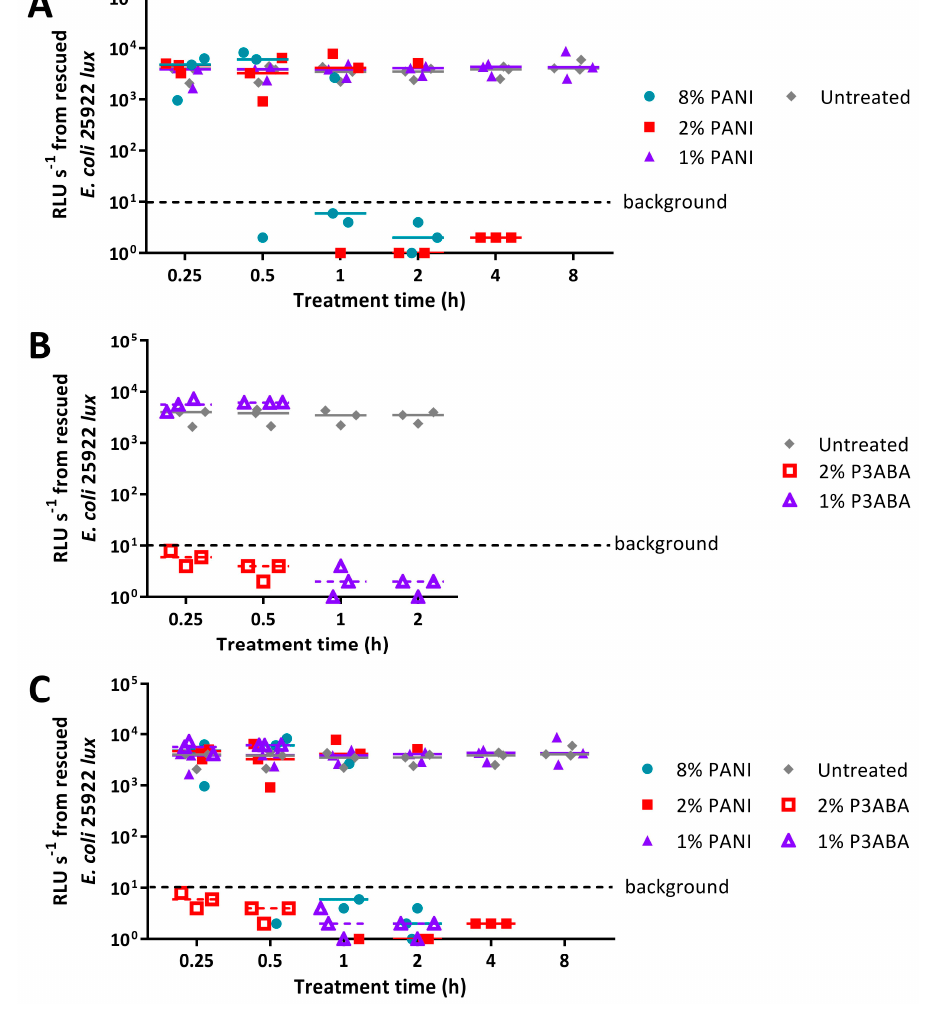
Figure 4. Sensitivity of E. coli 25922 lux to PANI and P3ABA in agar. ( A ) ~10 4 CFU of E. coli was exposed to 8% PANI, 2% PANI, and 1% PANI incorporated into LB agar for 0.25 h, 0.5 h, 1 h, 2 h, 4 h, and 8 h. ( B ) ~10 4 CFU of E. coli was exposed to 2% P3ABA and 1% P3ABA incorporated into LB agar for 0.25 h, 0.5 h, 1 h, and 2 h. Following treatment, the cells were rescued by washing the agar surface with LB broth and transferred to a 96 well plate. Each point represents the median of three technical replicates and each bar represents the median of each biological replicate. The data from A and B is combined for comparison in ( C ). The rescued cells were incubated at 37 °C for 16 h and light release was measured. The vertical axis shows the bioluminescence measurements (relative light units per second, RLU s − 1 ) from the recovered cells with each data point representing an independent experiment and the line representing the median. Background luminescence readings are ~10 RLU s − 1 . PANI in agar was less active against S. aureus 6538 than E. coli 25922 lux, reflecting the trend observed with suspension testing (Figures 2A, 4A, and 5A). Agar containing 2% and 8% PANI reduced S. aureus surface load to background levels within 8 h and 4 h, respectively (Figure 5A). The limit of detection for this assay is ~20 CFU (Figure A4). As observed for E. coli , 1% PANI in agar was inactive against S. aureus within the time constraints (8 h) of the experiment (Figures 4A and 5A). The viability of S. aureus cells following treatment with 8% PANI in agar for 2 h, 4 h, and 8 h, and following treatment with 2% PANI in agar for 8 h was significantly different from that of untreated cells (Friedman test, p value: less than 0.05, Dunn’s multiple comparison test).